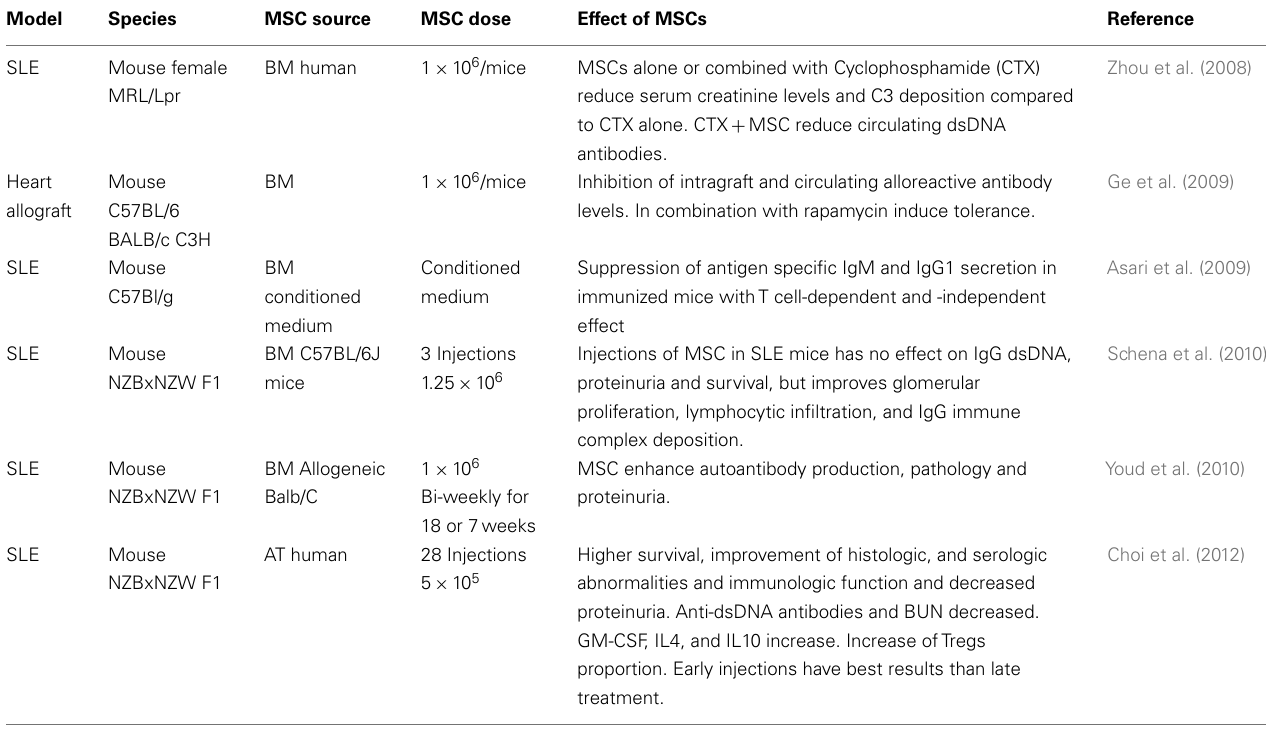
Table 2 | Effect of MSCs on B cells in vivo